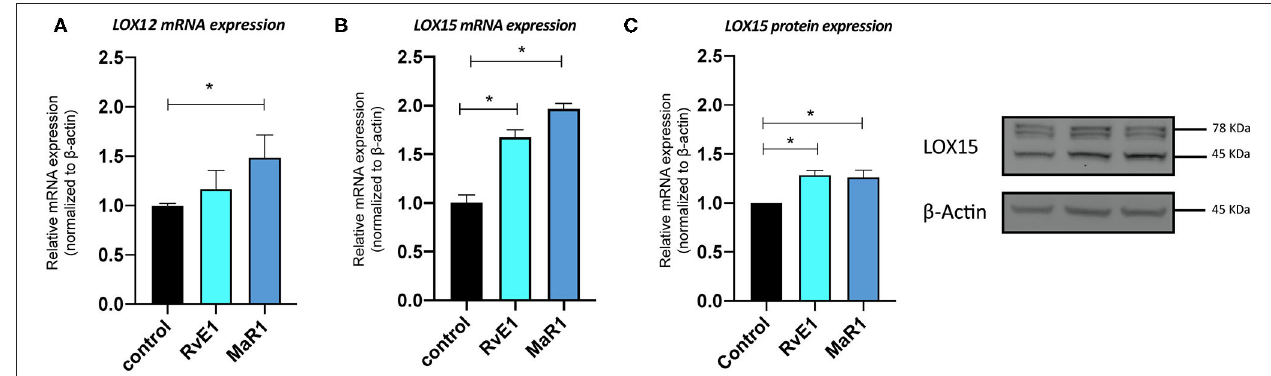
FIGURE 1 | Specialized proresolving mediators (SPMs) elevate 12-lipoxygenase (LOX12) and 15-lipoxygenase (LOX15) enzymes in pig periodontal ligament stem cells (pPDLSCs). pPDLSCs had elevated messenger RNA (mRNA) levels of LOX12 and LOX15 after being challenged with Maresin1 (MaR1) or resolvin E1 (RvE1) (10nM) and elevated mRNA of LOX12 after challenge by MaR1 at 24h (A,B) . At 48h, LOX15 enzyme was slightly increased by SPMs by the Western blot ( p < 0.05) (C) . Densitometry was performed by using the Image J for the two independent replicates of the Western blots. Error bars represent SDs. * p < 0.05.